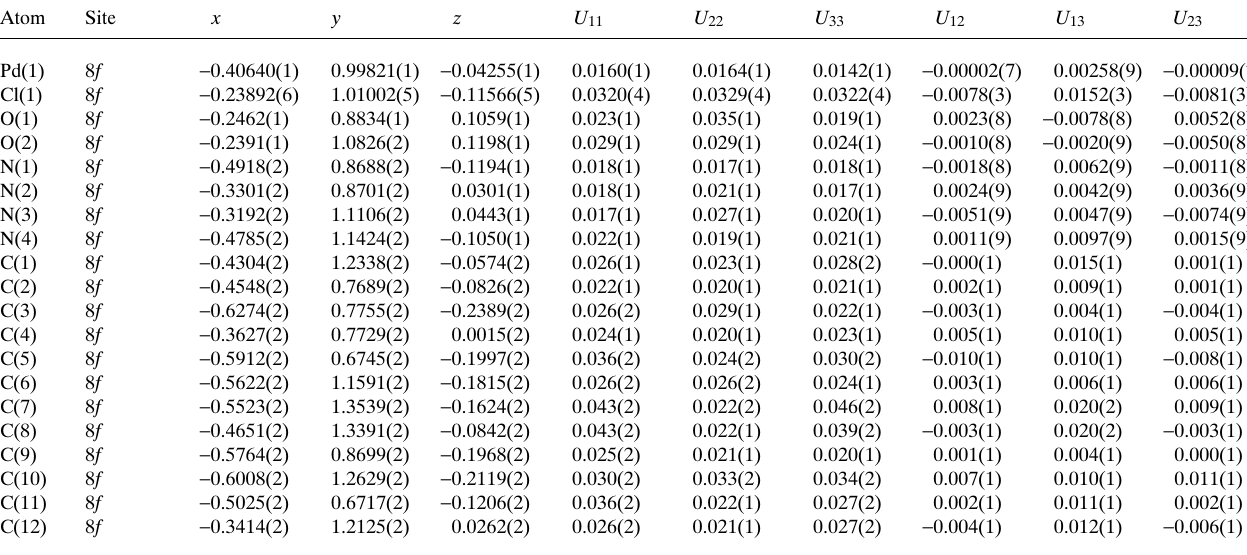
Table 3. Atomic coordinates and displacement parameters (in Å 2 )